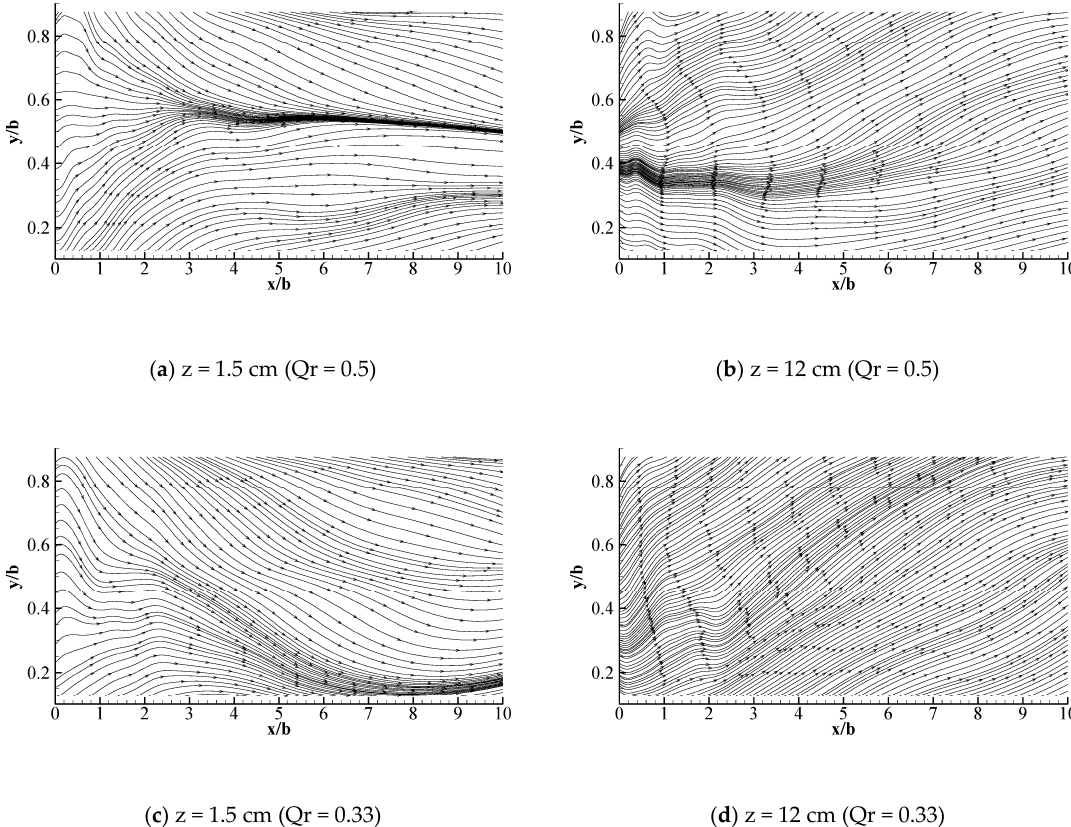
Figure 7. Longitudinal and horizontal streamline diagrams for the intersecting water flows.